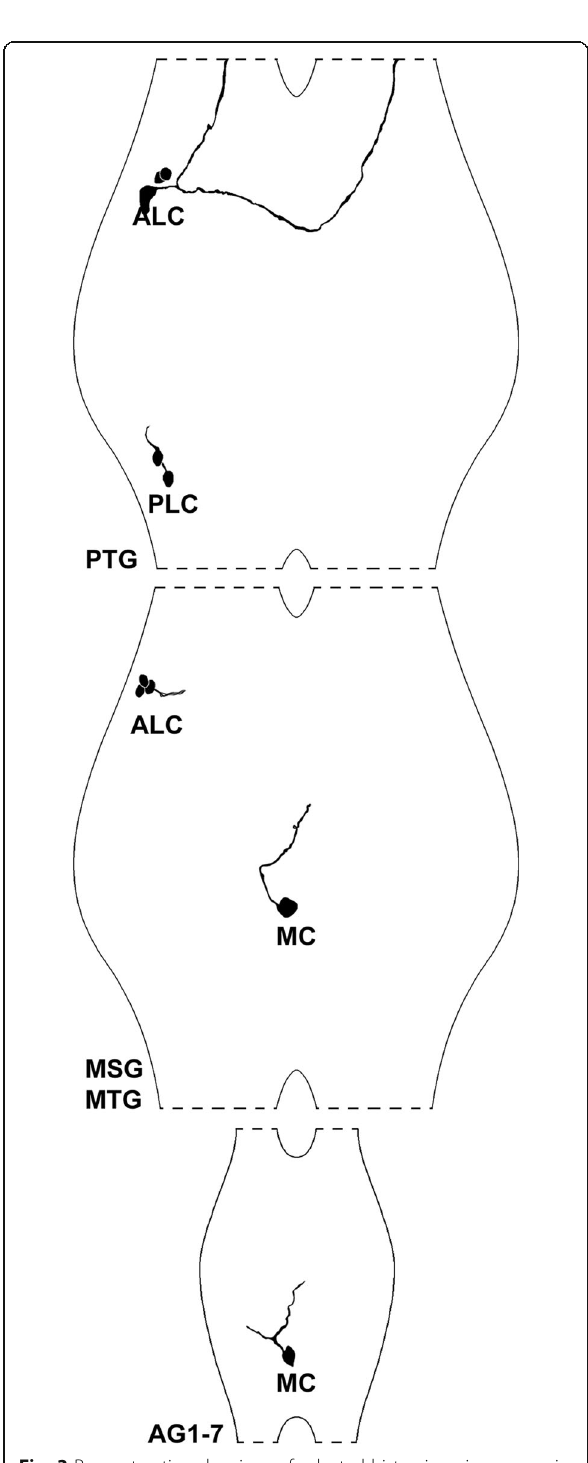
Fig. 3 Reconstruction drawings of selected histaminergic neurons in the thoracic and abdominal ganglia of Thermobia domestica . Only neurons from the left hemiganglion were depicted for clarity. Abbreviations: AG1 – 7: abdominal ganglia 1 – 7; ALC: anterolateral cell bodies; MC: medial cell bodies; MSG: mesothoracic ganglion; MTG: metathoracic ganglion; PLC: posterolateral cell bodies; PTG: prothoracic